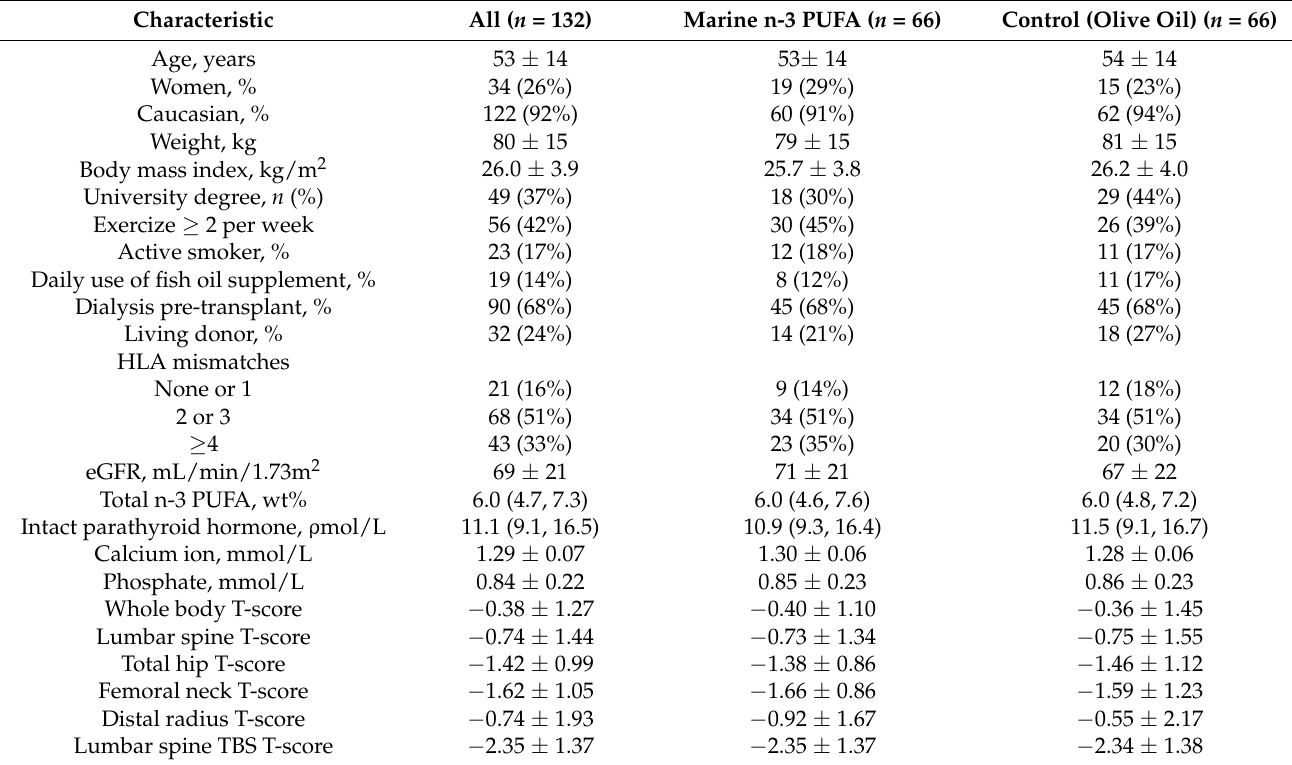
Table 1. Baseline data of participating adult kidney transplant